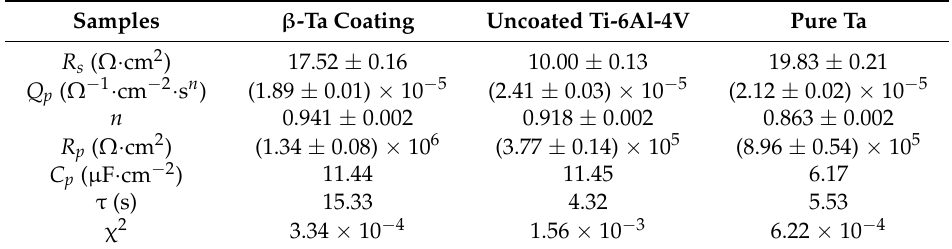
Figure 6. ( a ) Nyquist and ( b ) Bode plots for the β -Ta coating, uncoated Ti-6Al-4V and commercially pure Ta at respective open circuit potential in Hank’s solution at 37 °C. Symbols are experimental data and solid lines are fitted results. The inset in ( a ) is the equivalent electrical circuit (EEC) used to fit the experimental impedance data. Table 2. Electrochemical parameters derived from impedance fitting for the investigated specimens at their respective open circuit potentials in Hank’s solution at 37 ◦